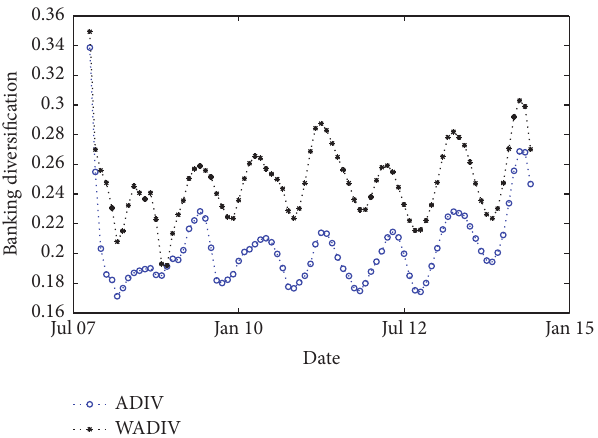
Figure 1: Banking diversification based on ADIV and WADIV. Figure 2: Banking systemic risk based on ADD and